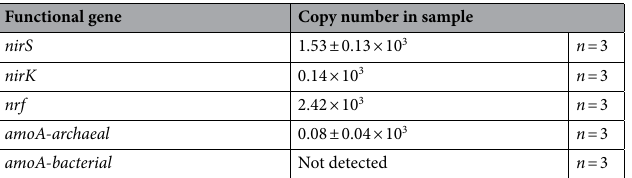
Table 1. Abundance of functional marker genes associated with N-cycling on the fiddler crab carapace. Note that nirK and nrfA was detected only in two of three samples. Average and standard errors are given.